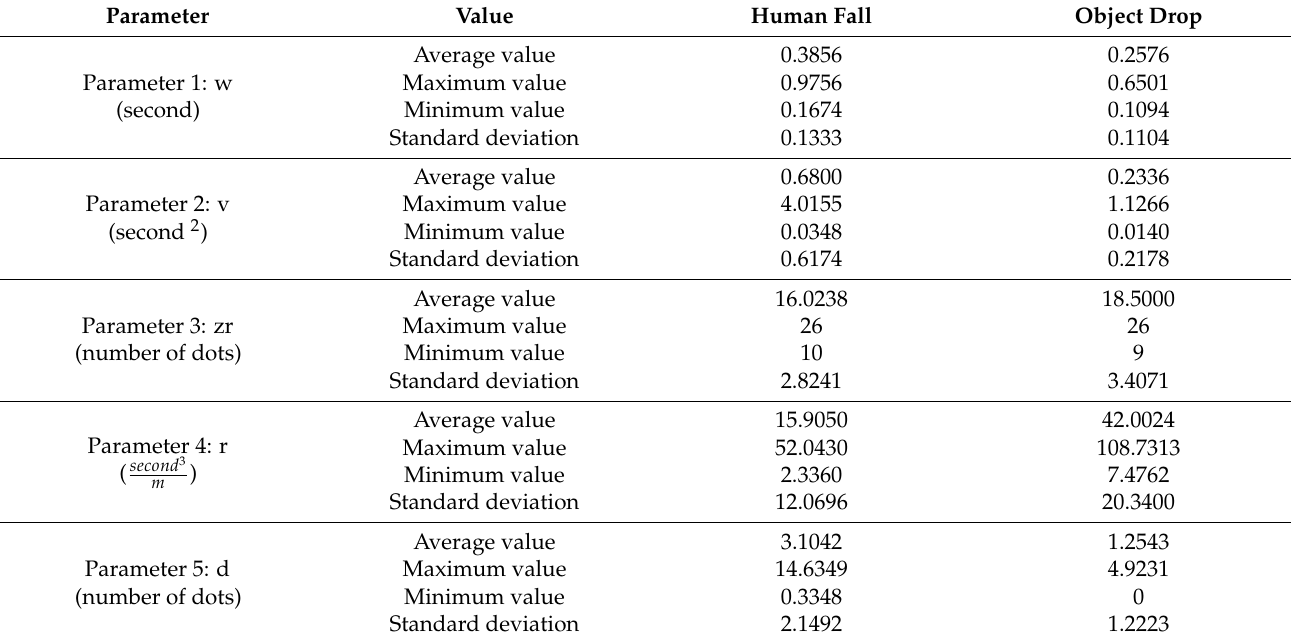
Table 5. Performance of selected parameters in different data sets.